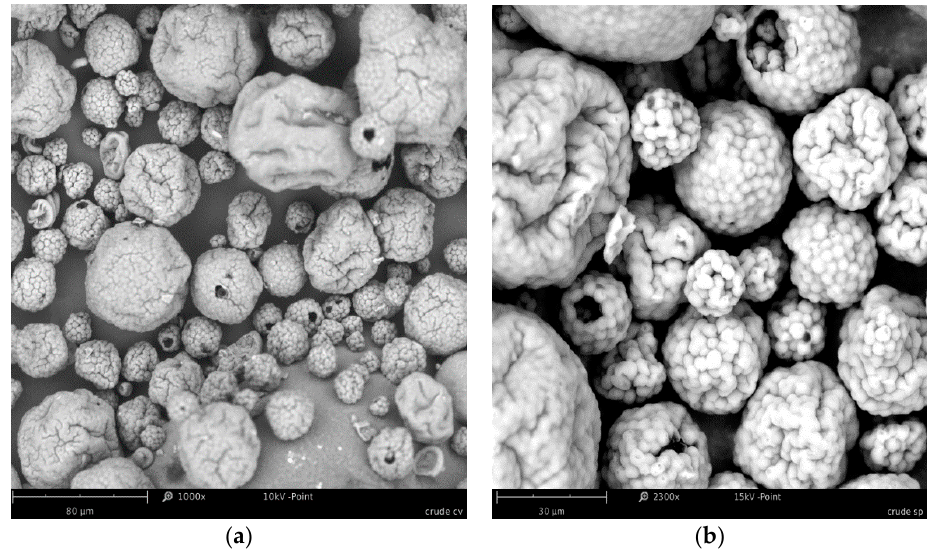
Figure A1. SEM image of dried microalgae, ( a ) Chlorella sp. at 1000× magnification 10 kV; ( b ) Spirulina sp. at 2300× magnification 15 kV.